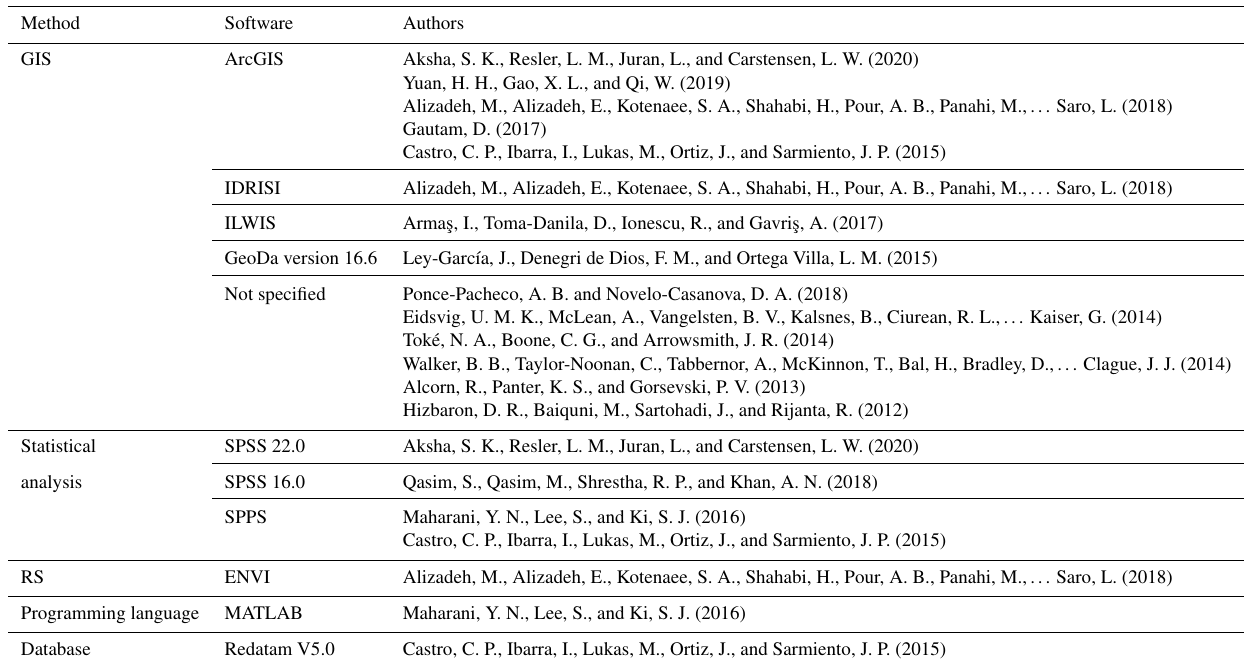
Table 8. Tools for socio-economic vulnerability